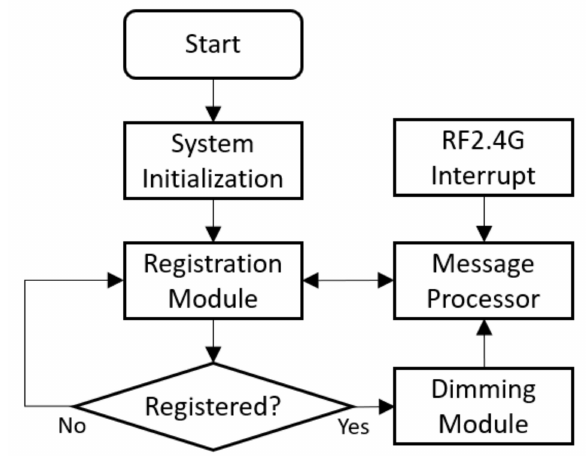
Figure 10. Software flowchart of LED driver control.